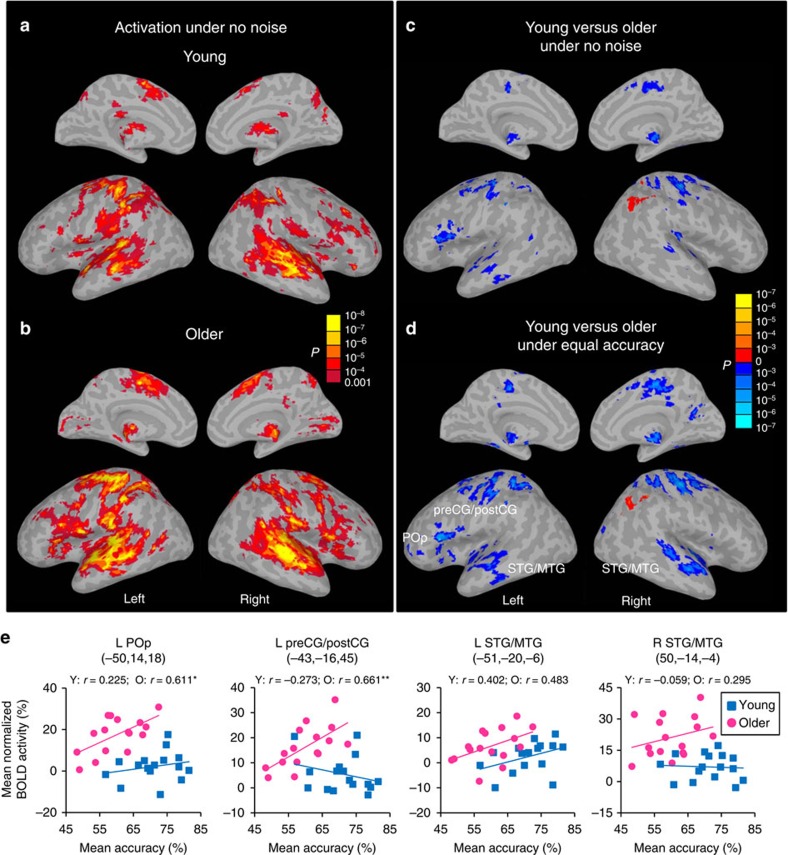
Age difference in BOLD activity.Activity elicited by syllable identification at the NoNoise condition in young (a) and older adults (b). Activity in young adults versus activity in older adults at the NoNoise condition (c) and conditions when two groups equalled in accuracy (average activity at −6 and −2 dB SNRs in young versus average activity at −2 and 8 dB SNRs in older) (d). Results are thresholded at PFWE<0.01. (e) Correlations between the mean activity across −12 to 8 dB SNRs in four ROIs (left POp, left preCG/postCG and bilateral STG/MTG) and the mean accuracy across those SNRs in older (red circles) and young adults (blue squares). The coordinates are in Talairach space. *P<0.05; **P<0.01 by Pearson's correlations. POp, pars opercularis; preCG/postCG, precentral and postcentral gyrus; STG/MTG, superior and middle temporal gyrus.